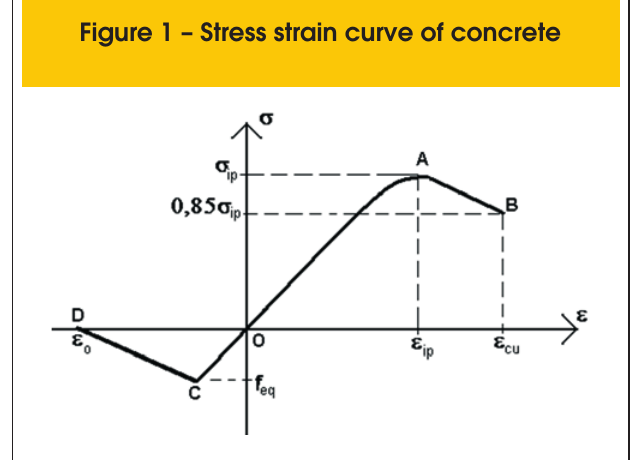
Figure 1 – Stress strain curve of concrete